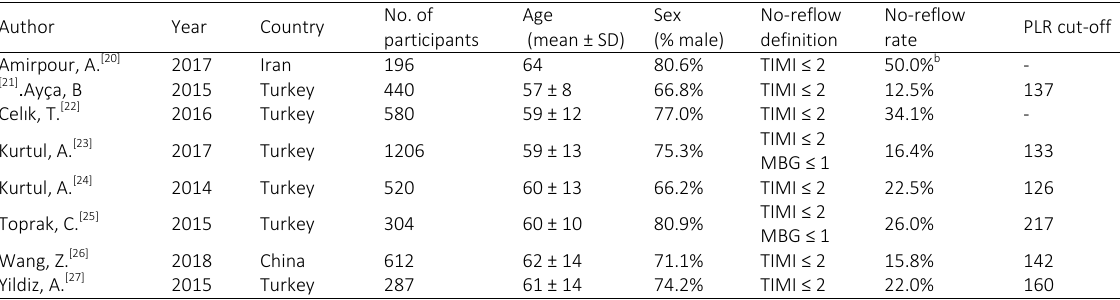
Table 1. Characteristics of the included